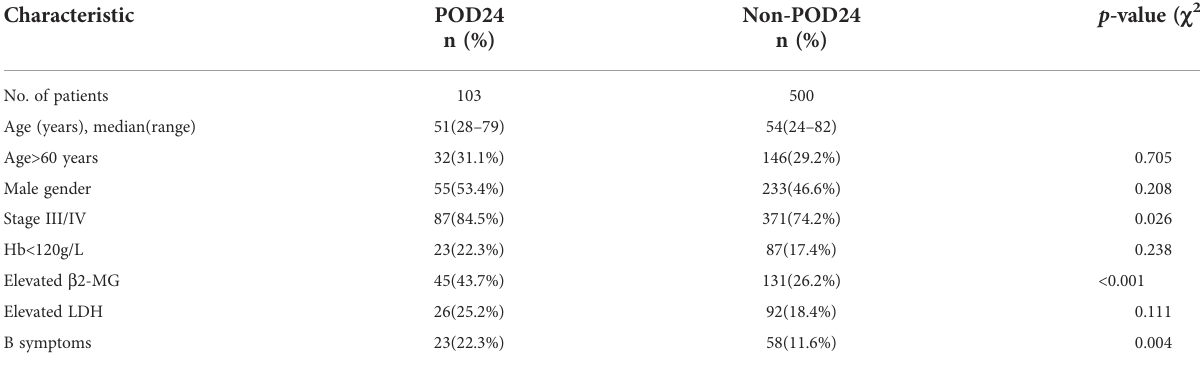
TABLE 3 Baseline demographics and clinical characteristics of POD24 and non-POD24 group. Characteristic